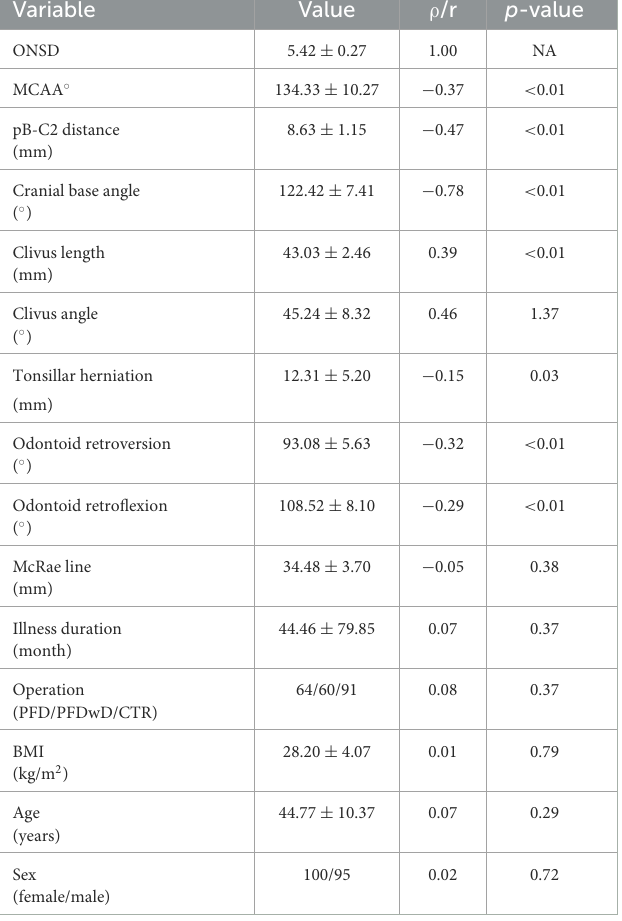
TABLE 1 Correlation of ONSD with other parameters by bivariate analysis, p < 0.05 is statistically significance. Variable